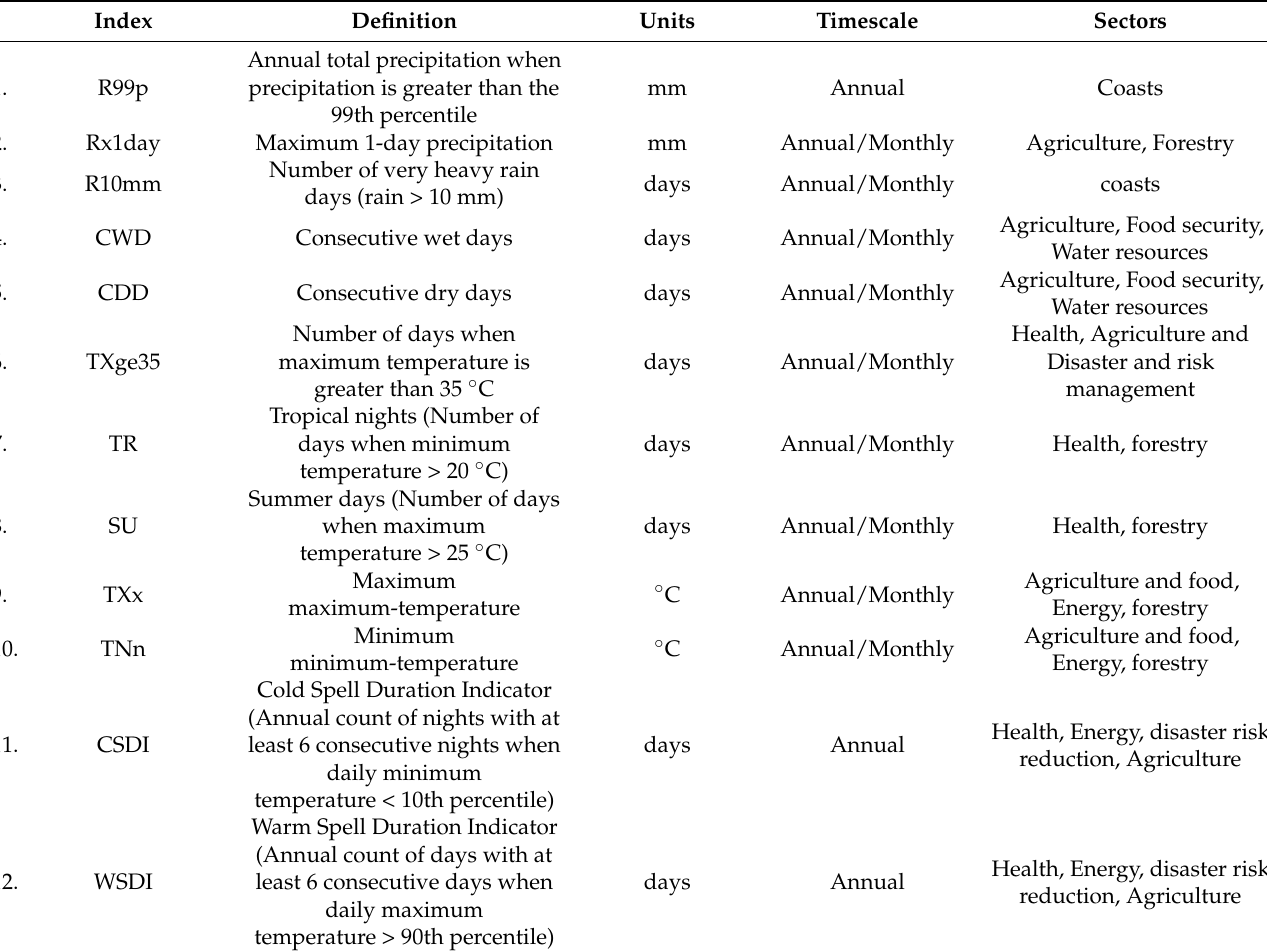
Table 2. List of ET-SCI Indices evaluated in this